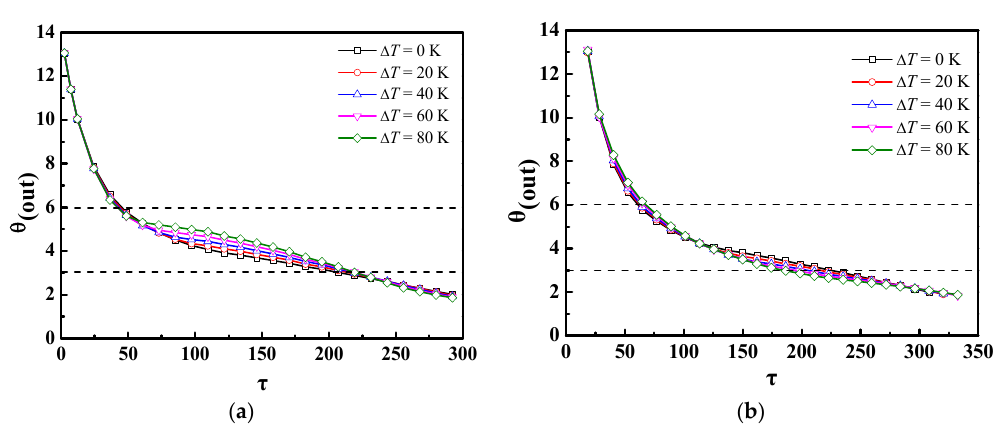
Figure 7. Dimensionless time evolution of the dimensionless outlet temperature. ( a ) Reversed arrangement; and ( b ) forward arrangement.